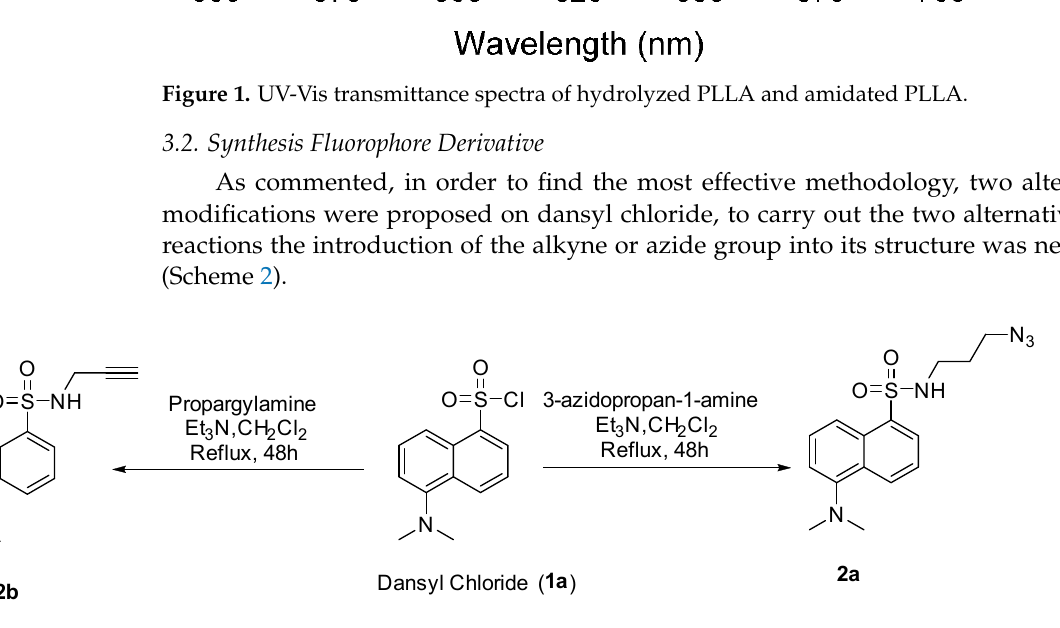
Scheme 2. Synthesis of two different dansyl derivatives.